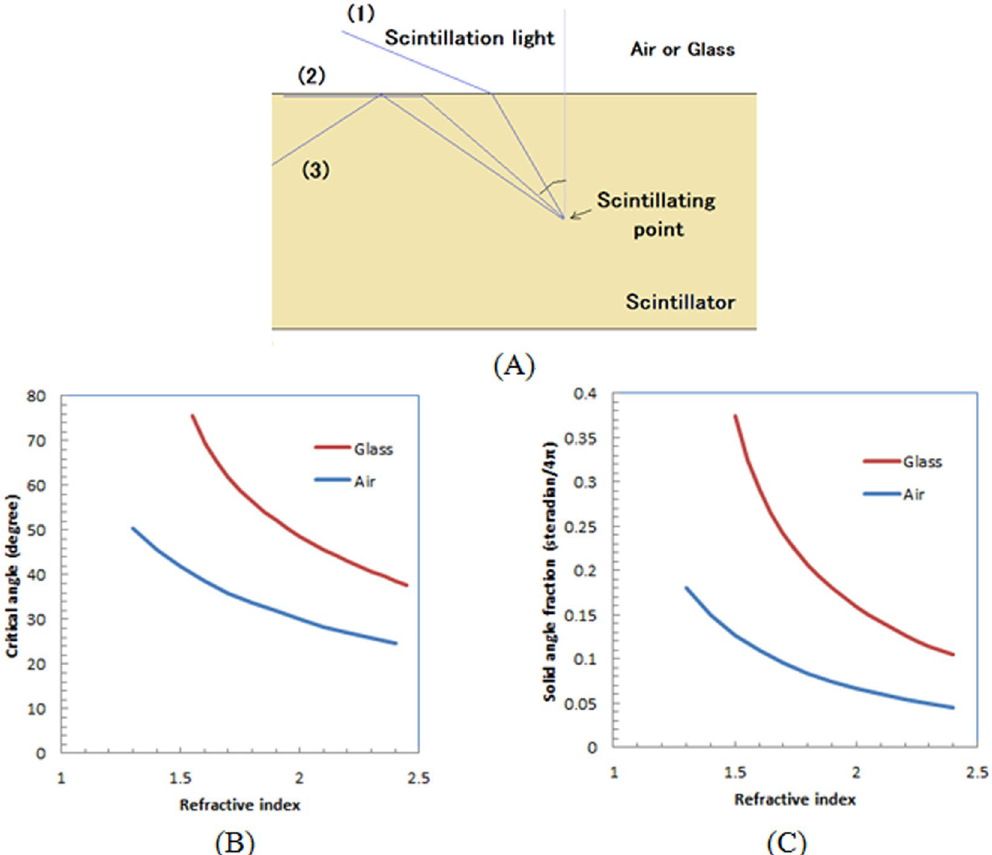
Figure 1. Schematic drawing of reflection of scintillation light inside scintillator plate ( A ), calculated critical angle ( B ), and solid angle fraction ( C ) as function of refraction index of